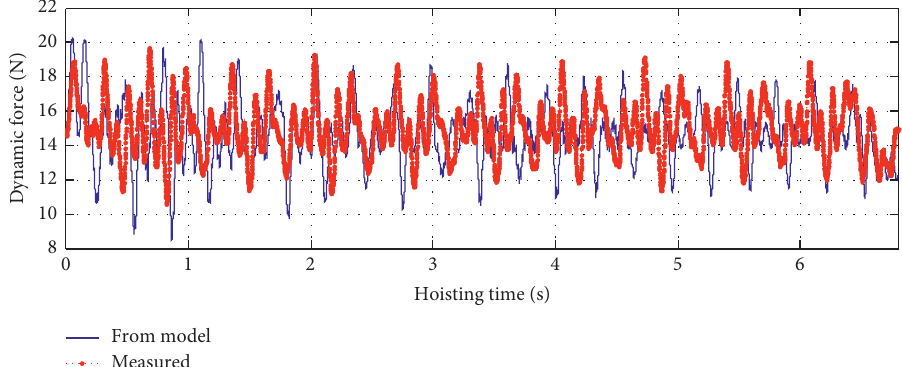
Figure 12: Dynamic forces at the conveyance end of the rope from model calculation and measurement.